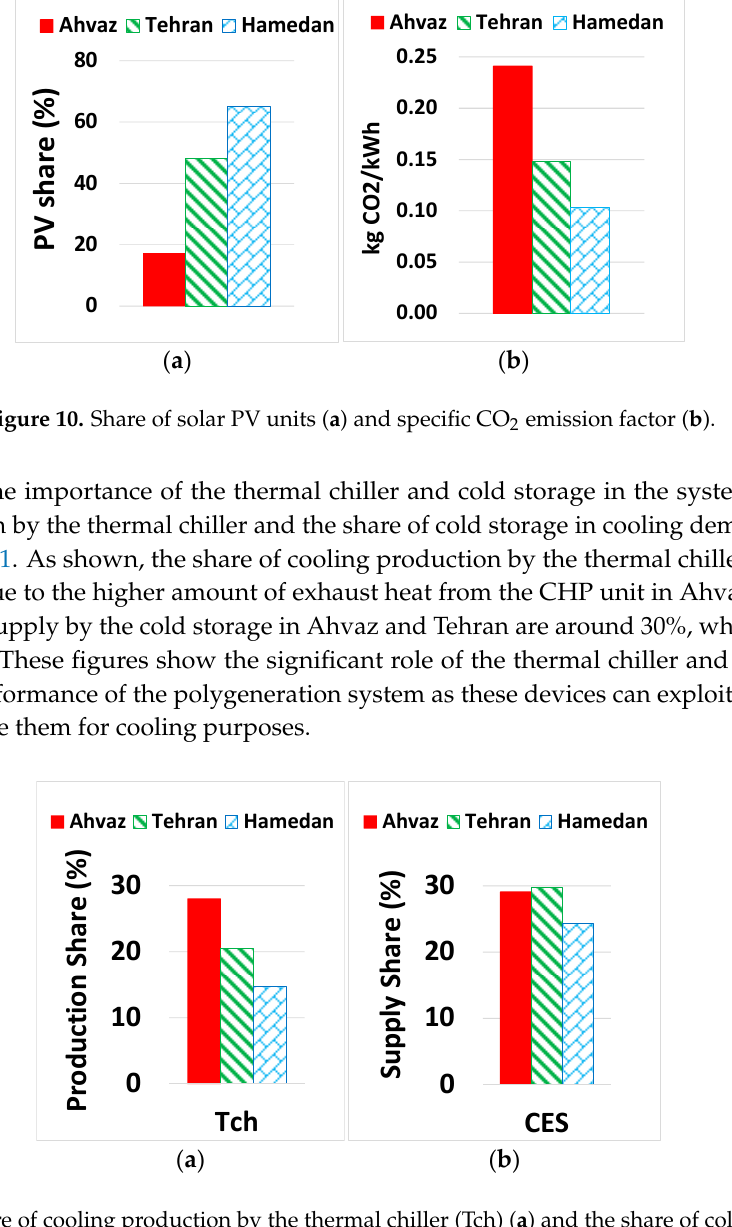
Figure 11. Share of cooling production by the thermal chiller (Tch) ( a ) and the share of cold storage in cooling demand supply ( b ).